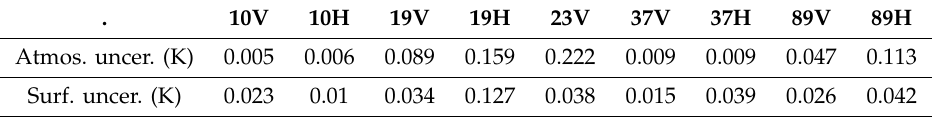
Table 5. Summary of derived individual uncertainty from all sources.